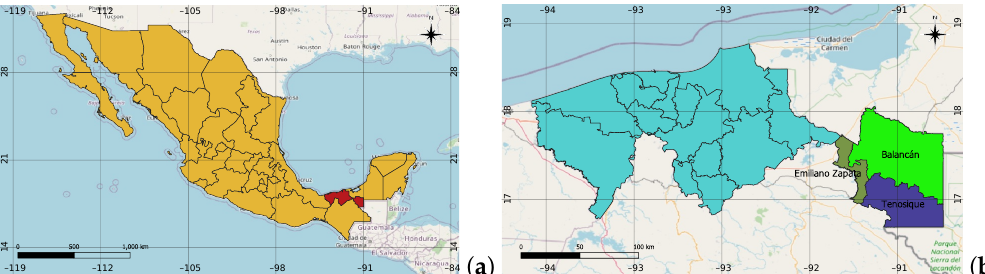
Figure 2. Study area map’s. ( a ) Tabasco in Mexico; ( b ) Study area.